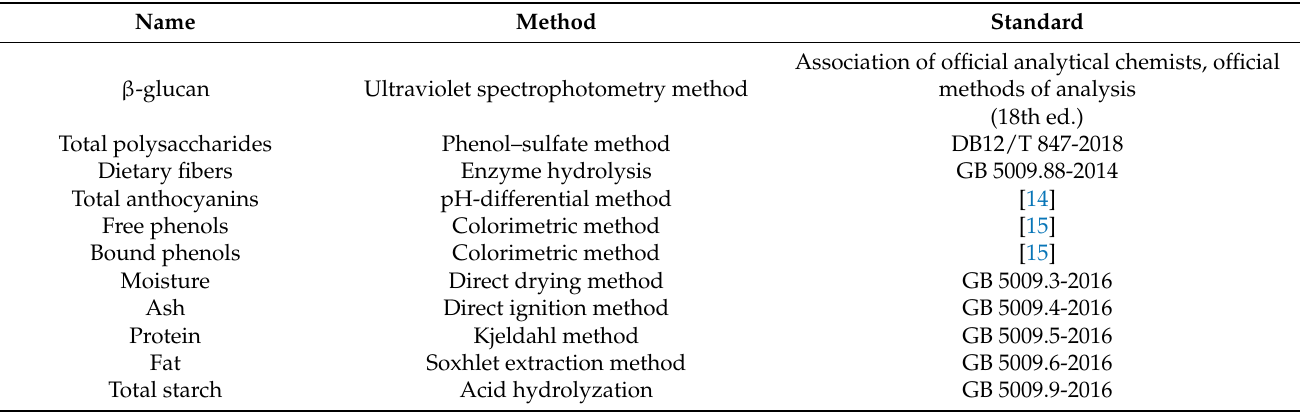
Table 1. Composition assessment of highland barley (HB), microwave fluidized highland barley (HB-I), extruded and puffed highland barley (HB-II), and ultrafine pulverized highland barley